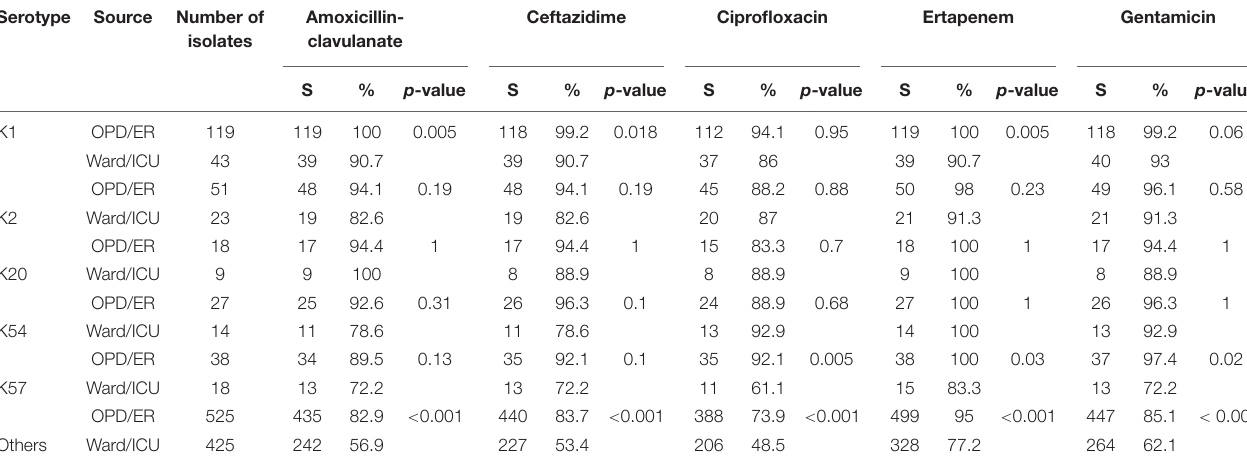
TABLE 5 | Antimicrobial susceptibility according to the source of patients and bacteremic Klebsiella pneumoniae serotypes. Serotype Source Number of